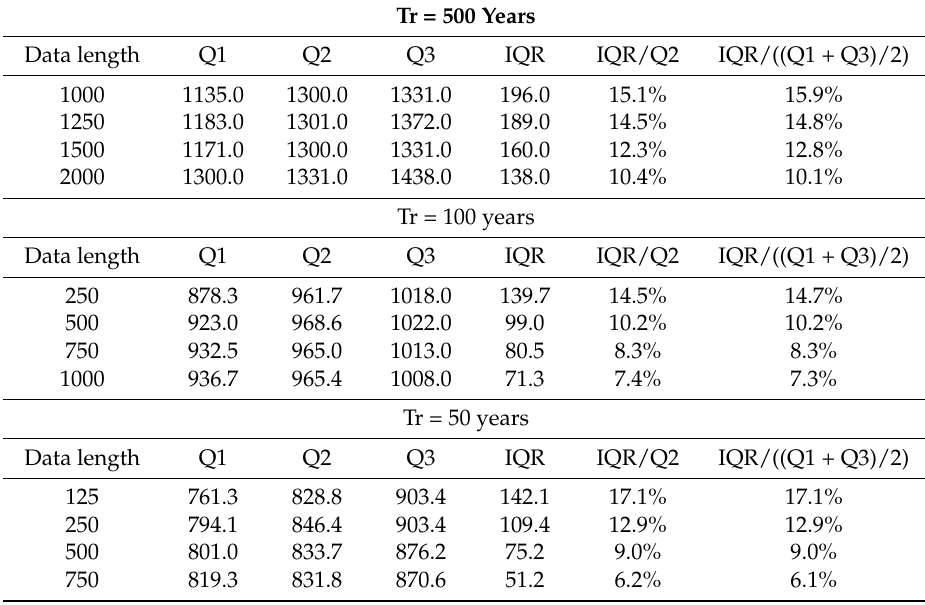
Table 6. Values of the first (Q 1 ), second (Q 2 ), third (Q 3 ) quartiles, the interquartile range IQR, and the relative value of the IQR against Q 2 and against the mean of Q 1 and Q 3 .